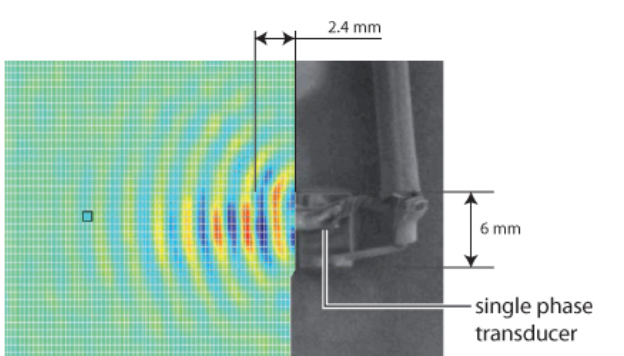
Figure 6. The calculated transition length of di ff raction of 2.4mm and the aperture of the transducer of 6mm are drawn in the scanning laser Doppler image for comparison.